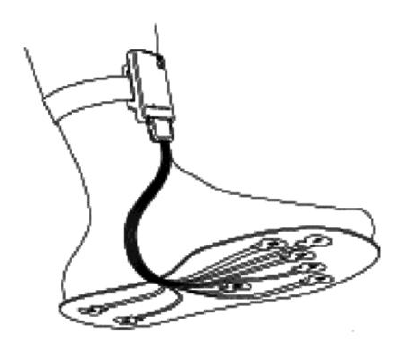
Figure 20. WalkinSense ® system